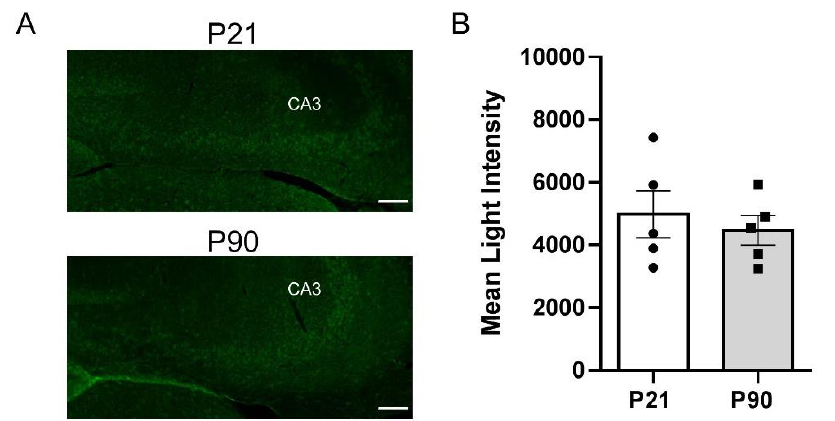
Figure 6. OCT3 expression in CA3 region of hippocampus is similar between juvenile and adult mice. ( A ) Representative 10× images from juvenile (P21) (top) and adult (P90) (bottom) mice. The mean intensity of light measurements was taken from the same area as that indicated in cell count data (Figure 3). ( B ) Summary data showing no difference in OCT3 expression between juvenile (open bar, circles) and adult (grey bars, squares) mice. Data are mean ± S.E.M. n = 5 per age. Scale bar = 100 µM.